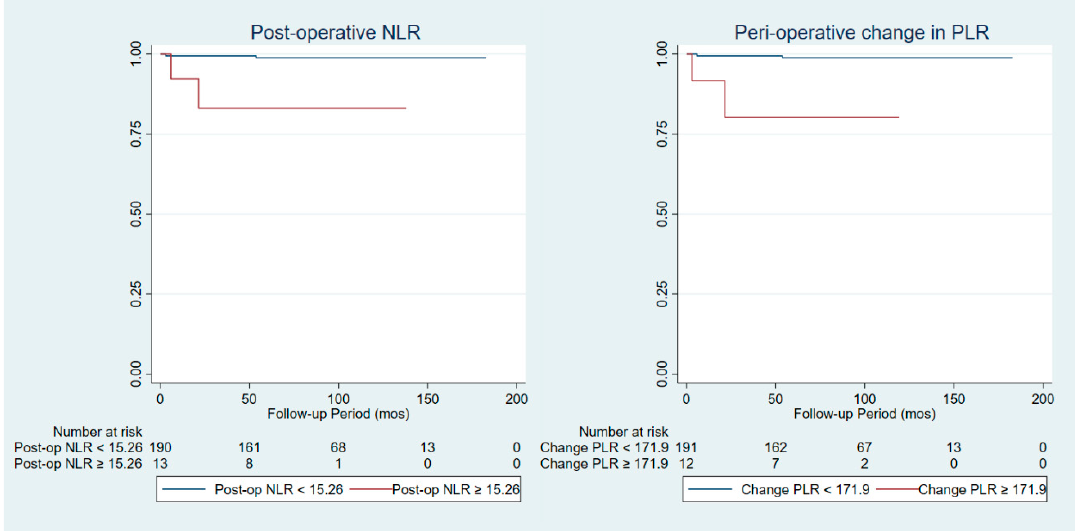
Figure 4. Kaplan–Meier graph outlining the relationship between NLR, PLR and metastasis-free survival.